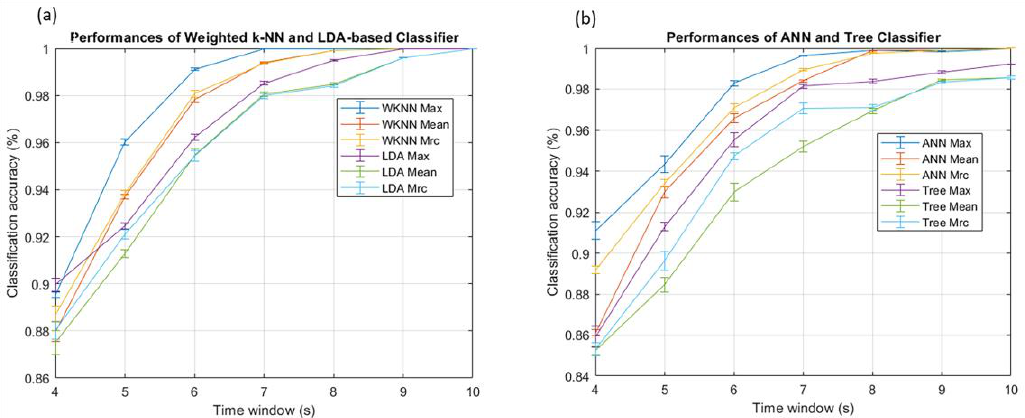
Figure 8. Classification performances of weighted k-NN, LDA-based classifier ( a ), ANN, and Tree Classifier ( b ) using a moving average